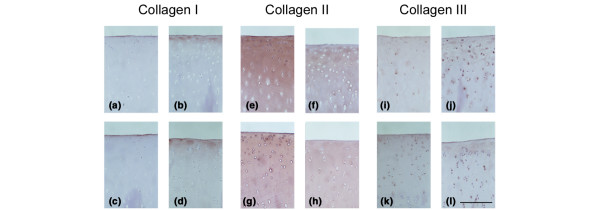
Immunolocalisation. Immunolocalization of types I (a–d), II (e–h) and III (I–l) collagens in medial (panels a, b, e, f, I and j) and lateral (panels c, d, g, h, k and l) tibial plateau cartilage. Sections from representative nonoperated control (panels a, c, e, g, I and k) and meniscectomized (b, d, f, h, j and l) joints are shown. Scale bar: 250 μm.